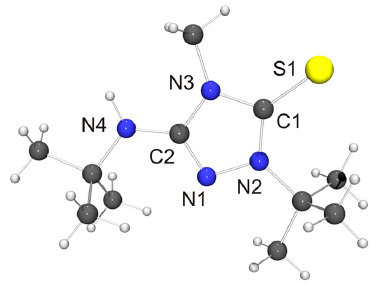
Figure 5. Molecular structure of the cation of thione 6 ′ = S in the crystal. Selected bond lengths [Å] and angles [°]: C1 ‒ N2 1.335(3), C1 ‒ N3 1.388(3), C1 ‒ S1 1.689(3), C2 ‒ N1 1.301(3), C2 ‒ N3 1.365(4), C2 ‒ N4